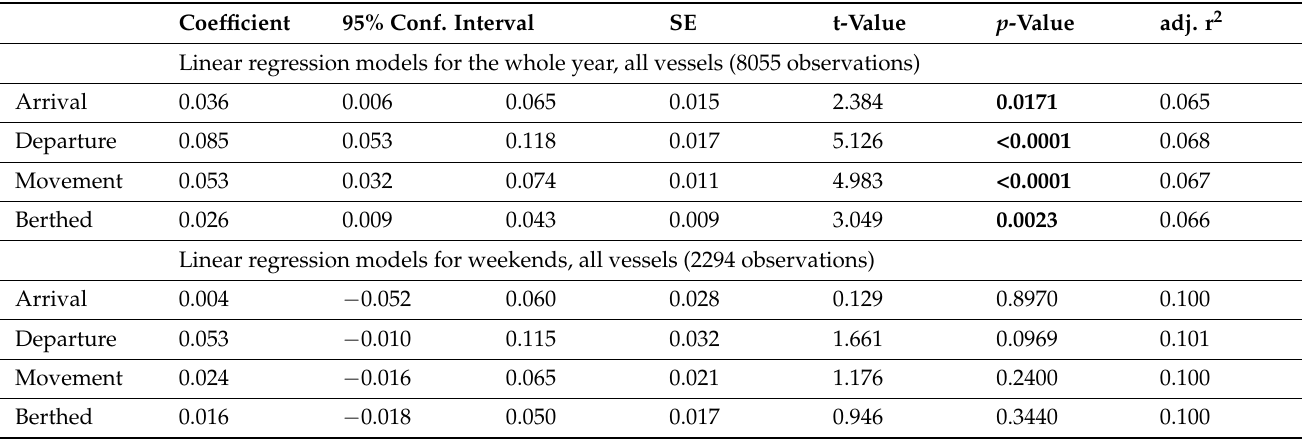
Table 9. Multivariable linear regression analysis results for vessel arrivals, departures, movement and laying alongside to the logarithm of PM 2.5 hourly mean concentrations controlled for wind direction, wind speed and time of day at the West Harbour in 2019. p -values less than 0.05 in bold. 95% Conf. Interval SE t-Value adj. r 2